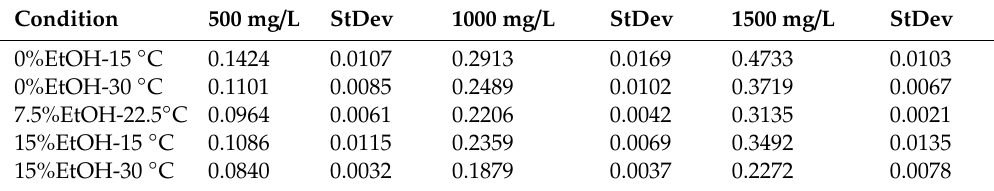
Table A3. Average mass PA adsorbed to cell wall material after system reached equilibrium in the absence of anthocyanins. Values derived from previous study [7] and represented in Figure 6. Values are presented in mg PA (C.U.) per mg CWM ( n = 3). Respective standard deviations are displayed to the right of each data point.